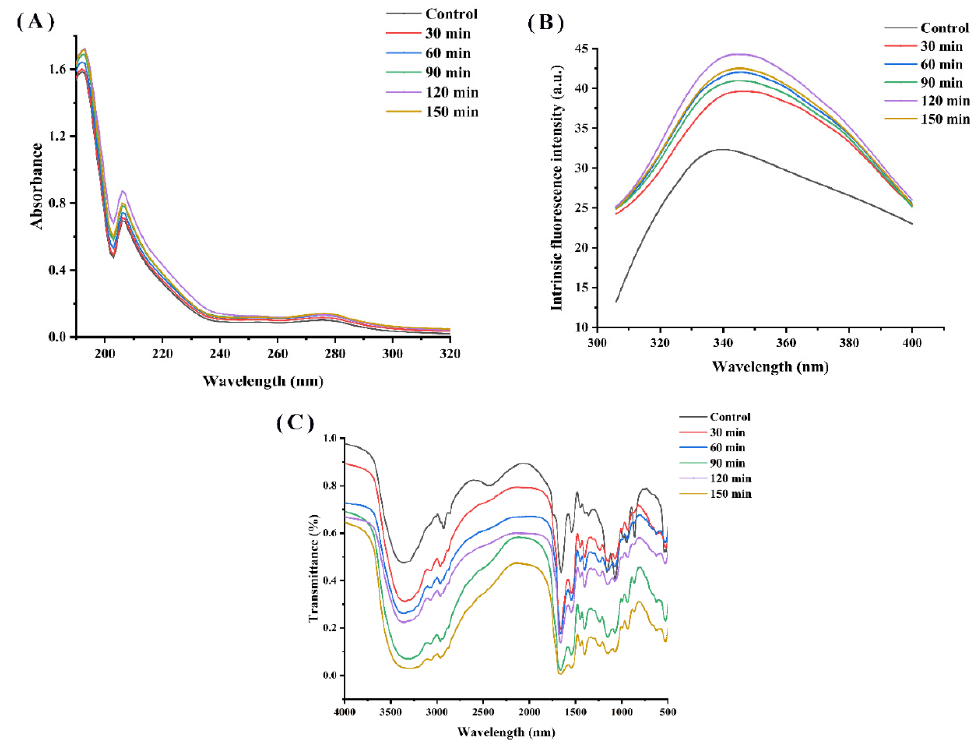
Figure 4. ( A ) UV absorption spectra, ( B ) endogenous fluorescence spectra and ( C ) FTIR spectra of walnut proteins with different enzymatic digestion times.